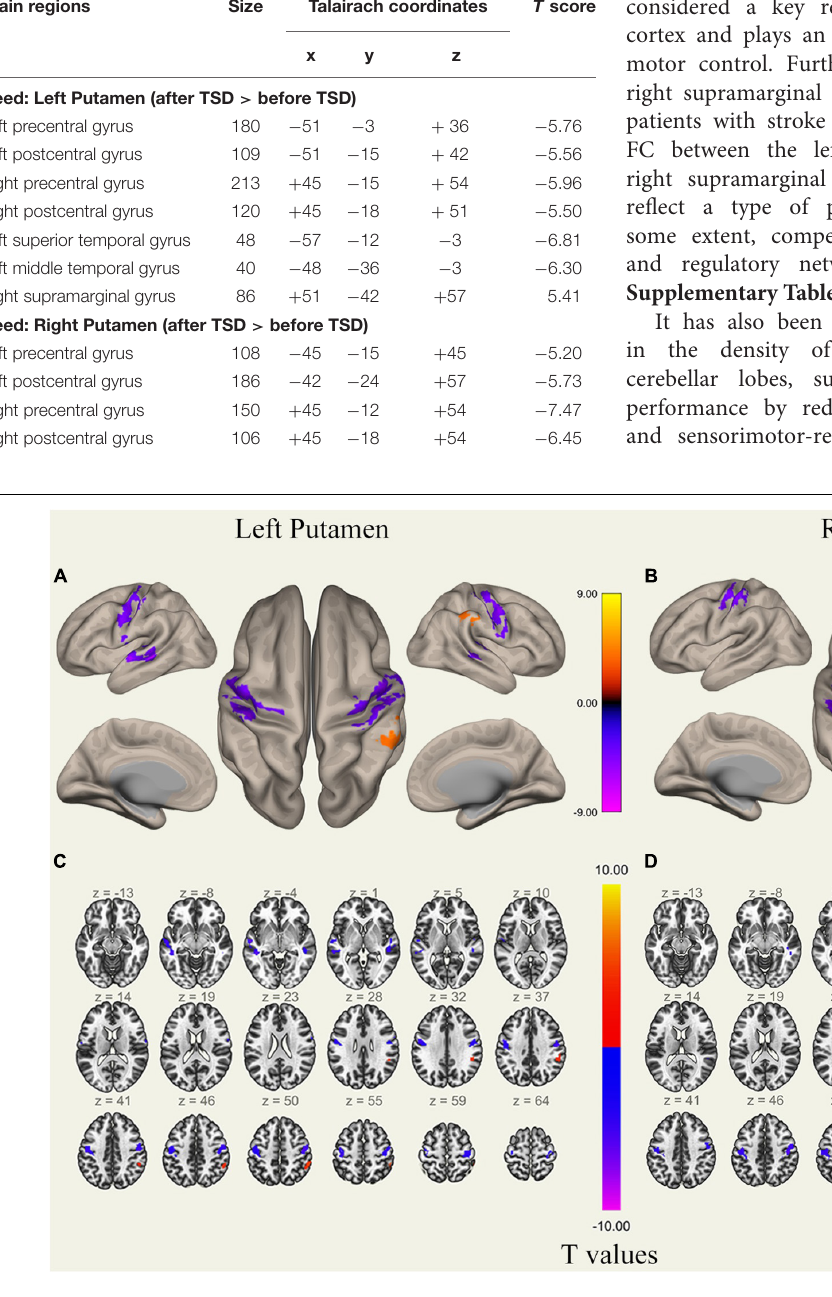
FIGURE 5 | Surface views shown at panels (A,B) and transverse views shown at panels (C,D) of brain areas that exhibited altered functional connectivity with bilaterally putamen after 36 h TSD ( n = 30). Warm colors indicate increased FC, and cold colors indicate decreased FC.